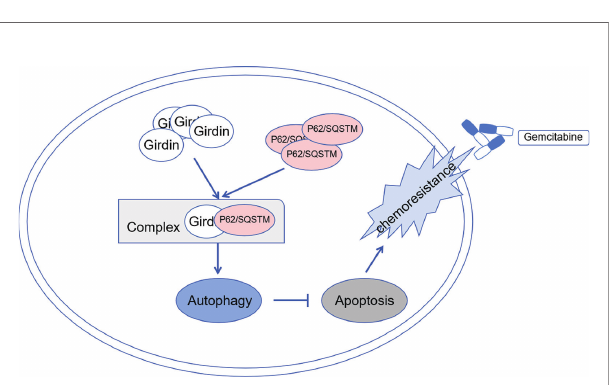
FIGURE 9 | Schematic diagram showing Girdin may activate protective autophagy of pancreatic cancer cells by directly binding to p62 form as a complex, and then increase the gemcitabine chemoresistance of pancreatic